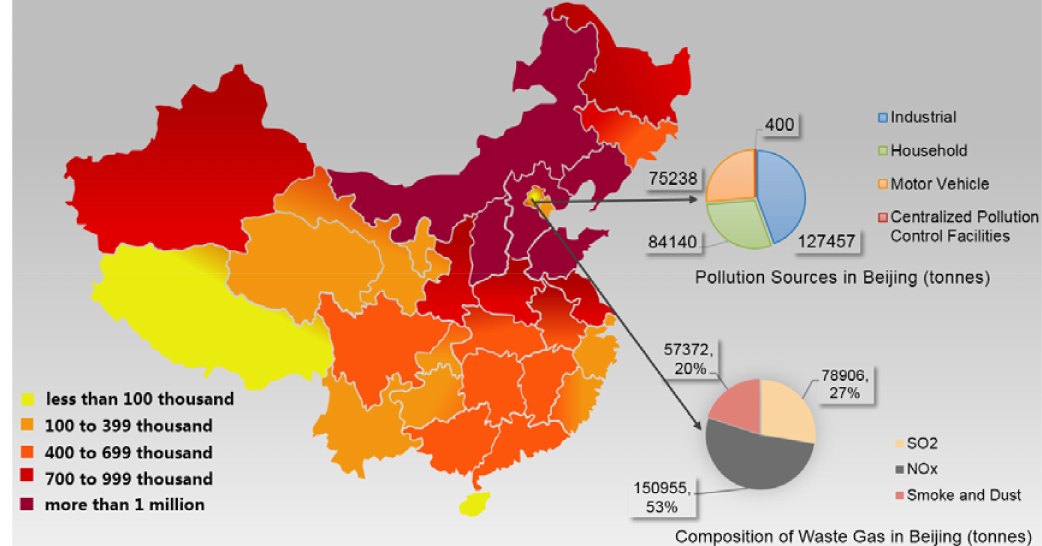
Figure 3. Waste gas emissions in different districts (tonnes) (Source: Drafted by authors according to online data from National Bureau of Statistics [64]).